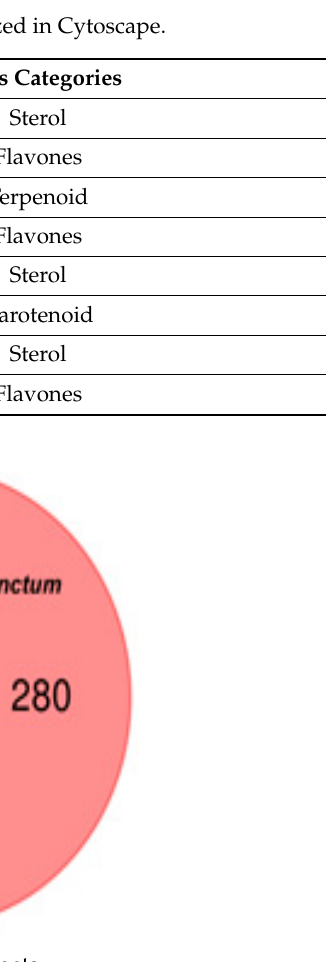
Figure 3. Venn diagram showing common targets.